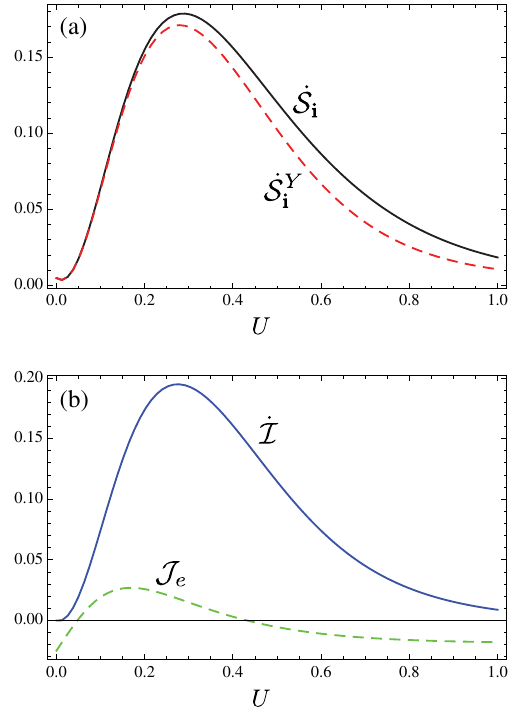
FIG. 4. Information engine: (a) Plot of total entropy production _ S _ S Y i i (solid black line) and entropy production in the lower dot _ I (dashed red line) as well as (b) information flow (solid blue line) and electronic current J e (dashed green line) as a function of interaction energy U . Parameters: μ D ¼ 1 − U= 2 , μ L ¼ 1 . 1 , μ 0 . 9 , T 0 . 1 , T ¼ 1 , ϵ ϵ 1 , Γ ¼ 100 , Γ ð L Þ Γ ð R Þ 1 . 5 , R ¼ D ¼ X ¼ Y ¼ 0 ¼ 1 ¼ L Þ Γ ð R Þ 0 . 5 and Γ ð 1 ¼ 0 ¼